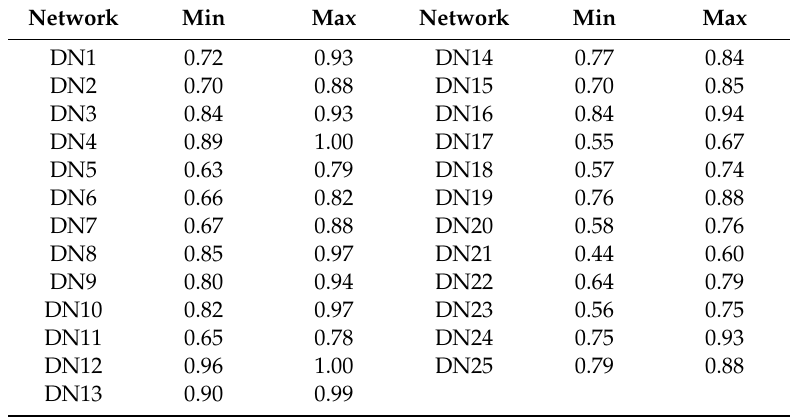
Table 2. Drainage Ratios in all 25 drainage networks. “Min” and “Max” are the minimum and maximum Drainage Ratios (DRs), corresponding to the rainfall scenarios of 115 and 60 mm, respectively.